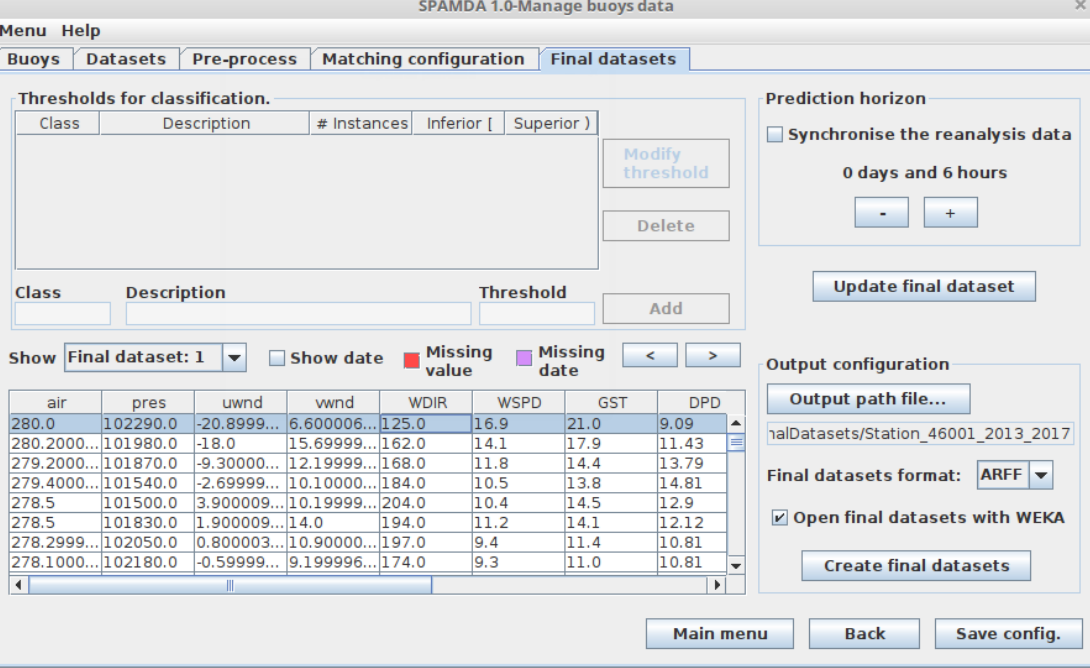
Figure 23. Final datasets tab: content of the final dataset created after data